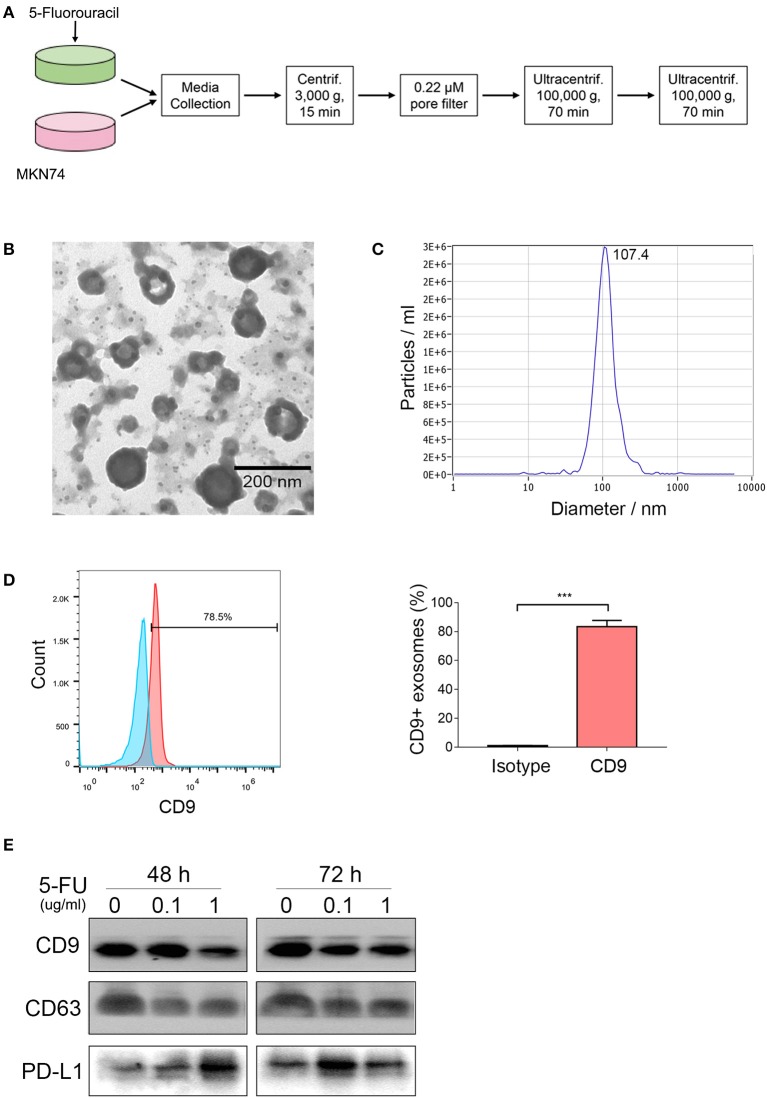
5-Fluorouracil (5-FU) increases the secretion of exosomal programmed death-ligand 1 (PD-L1). MKN74 cells were incubated with 5-FU (0, 0.1, 1.0 μg/ml) for 48 and 72 h, respectively. (A) Schematic illustration of MKN74 cell-derived exosomes isolation and purification from the supernatants by ultracentrifugation. (B) MKN74-derived exosomes were validated by transmission electron microscopy (TEM). Scale bar: 200 nm. (C) Size distribution of exosomes was analyzed by Nanosight. (D) CD9 levels on the surface of exosomes were detected by flow cytometry analysis. Data represent mean ± SD, and Student's t-test was used to evaluate the statistical significance (***P < 0.001). (E) Western blot analysis of exosomes biomarker CD9 and CD63, and exosomal PD-L1 amounts. Equal amounts of proteins obtained from exosomes were immunoblotted with anti-CD9, anti-CD63, and anti-PD-L1 antibodies.